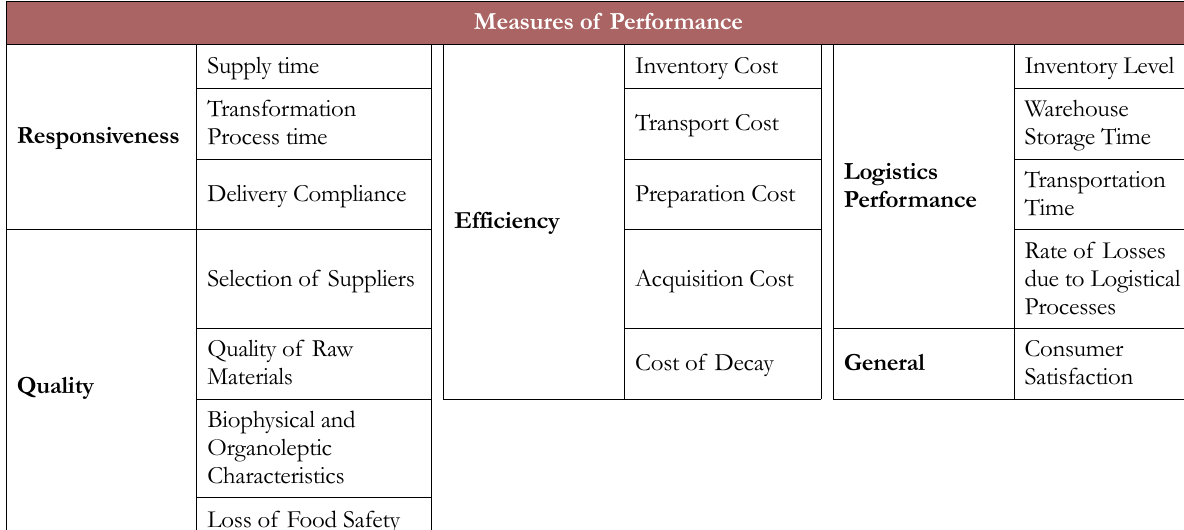
Table 2. Performance measures of the SCs